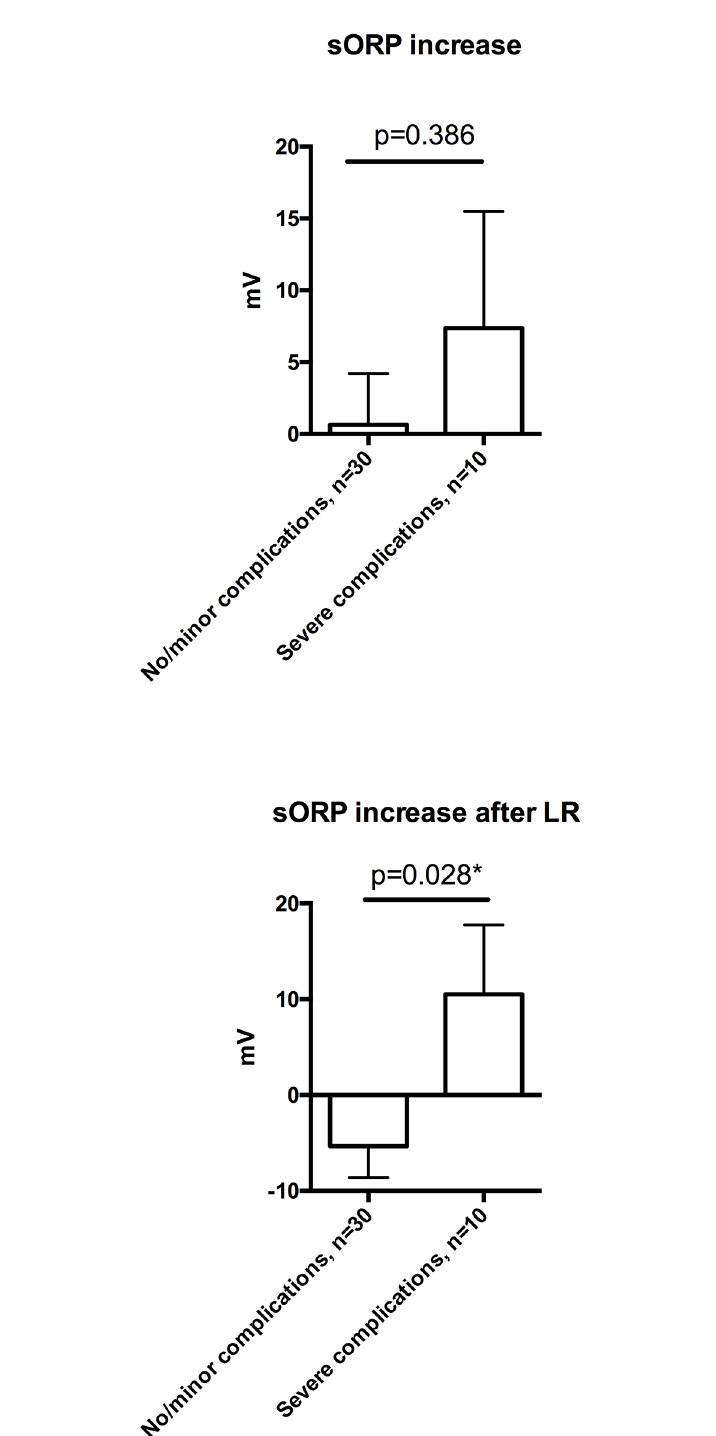
Fig 2. Change in OS is associated with severepost-operative complication. (A) Mean sORP increase duringLR was higherin patients who developeda severe post-operative complicationcomparedto patients with no/minor post-operative complication (0.6 (3.6) mV vs. 7.4 (8.1) mV; p = 0.386). (B) Measuringthe increaseof OS after LR revealed a significantly increasedresponse in patients with severe morbidity comparedto patients without (-5.3 (3.3) mV vs. 10.5 (7.3) mV; p = 0.028). Data are expressedas means with standarderror of the mean (SEM) and comparisonwas performed by using an unpairedt-test. * p < 0.05.